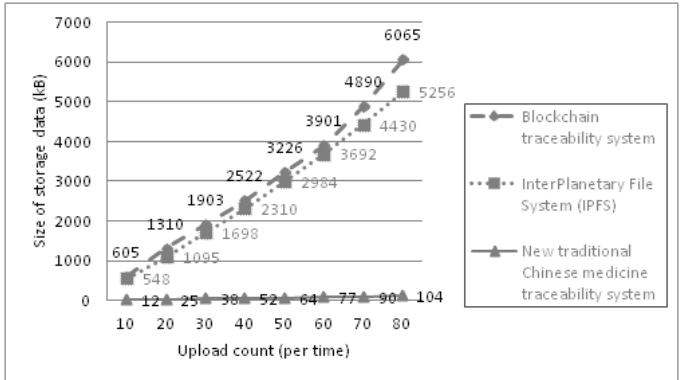
Figure 5. Comparison of the increase of the storage space according to the size of the data